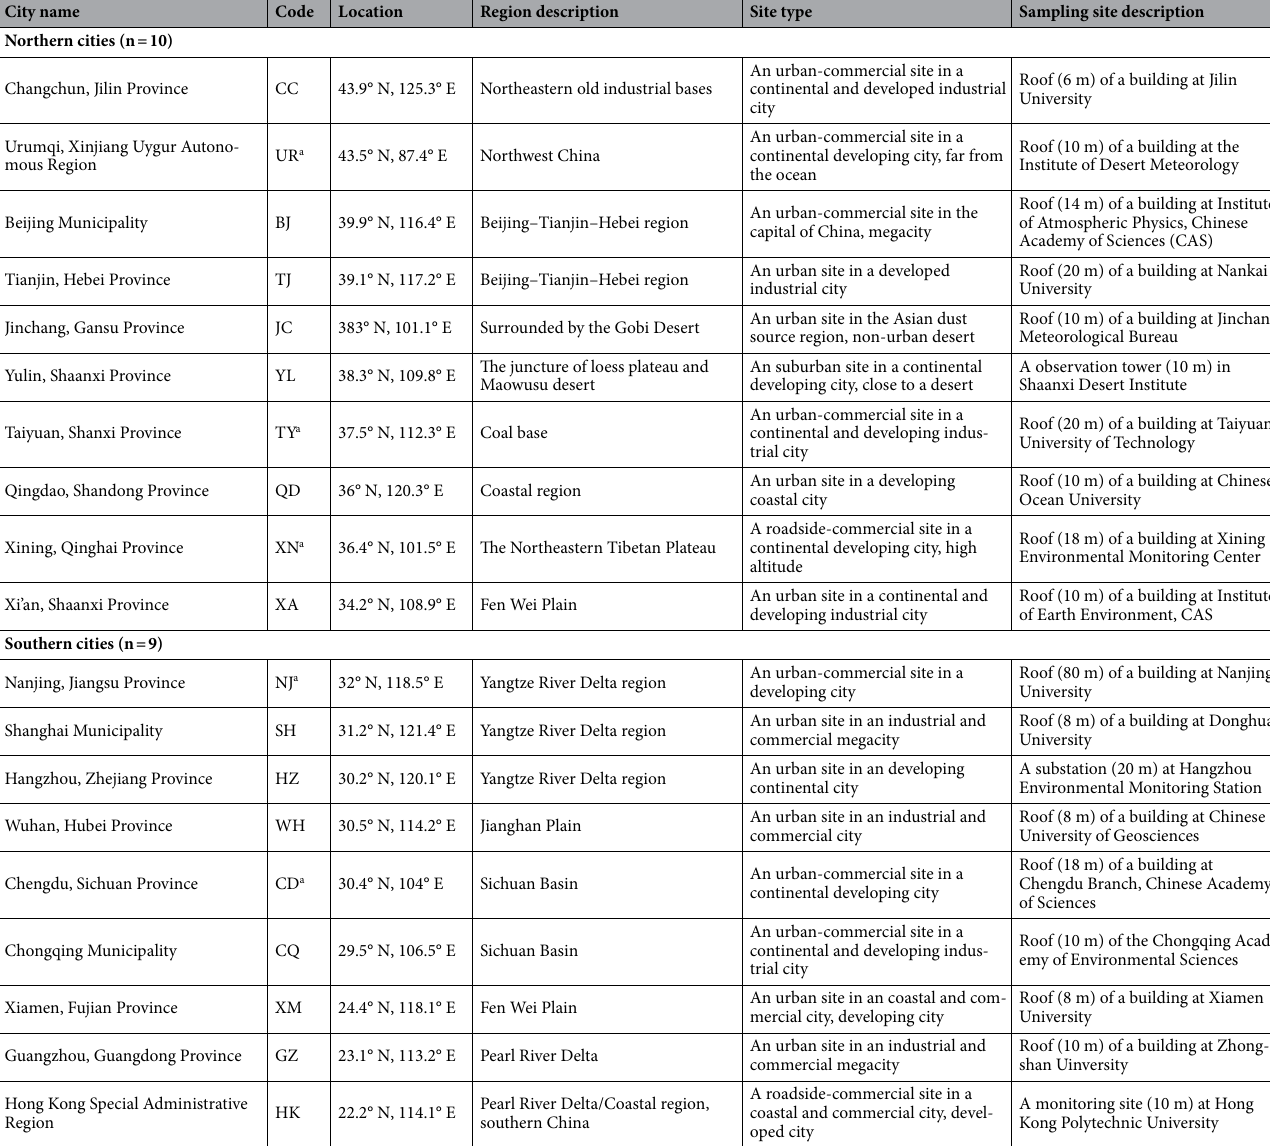
Table 1. Location and description of sampling sites in 19 cities for 2013 and 14 cities for 2003. a The five cities that are not included in the 2003 study 24